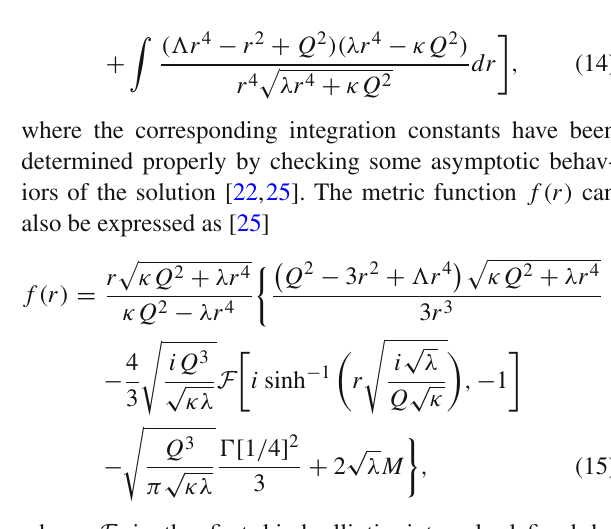
Fig. 1 The plots of the metric function f ( r ) and the parameter space ( Q ,κ) with respect to black